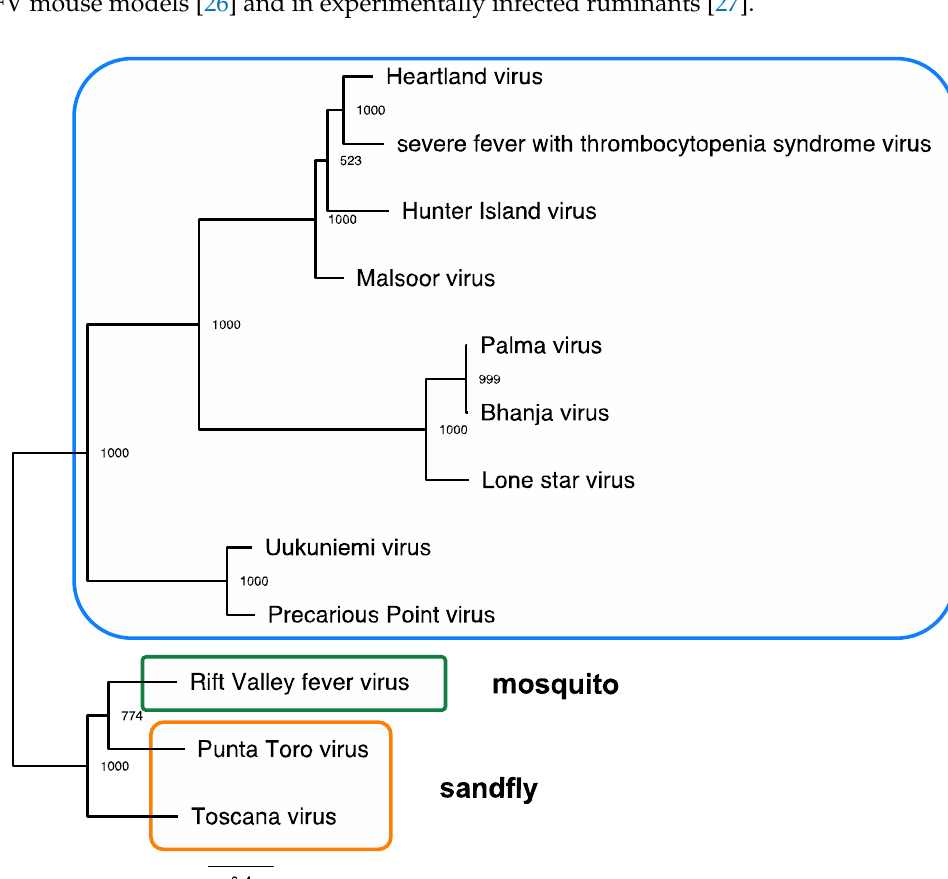
Figure 1. Maximum-likelihood tree showing genetic relationships among the tick-borne, mosquito-borne, and sand-fly-borne phleboviruses. A maximum-likelihood phylogeny based on amino-acid sequences from the large (L) segment from representative strains was generated in PhyML using amino-acid sequences. Bootstraps are indicated on nodes, and tick, mosquito, and sand-fly vector associations are indicated by colored boxes. The scale bar represents the mean amino-acid substitutions per site. Accession numbers: Uukuniemi virus D10759; Precarious Point virus HM566181; Toscana virus FJ153281; Rift Valley fever virus JQ068144; Punta Toro virus KR912212; Lone Star virus NC 021242; Palma virus JQ956379; Bhanja virus JQ956376; Hunter Island virus KF848980; Malsoor virus KF186497; Heartland virus JX005846; severe fever with thrombocytopenia syndrome virus HM745930.